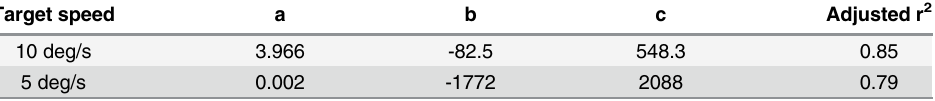
Table 1. Parameters and fit for the modelled relationship between speed of dazzle texture and change in perceived speed for the 10 deg/s target (Experiment 1) and the 5 deg/s target (Experiment